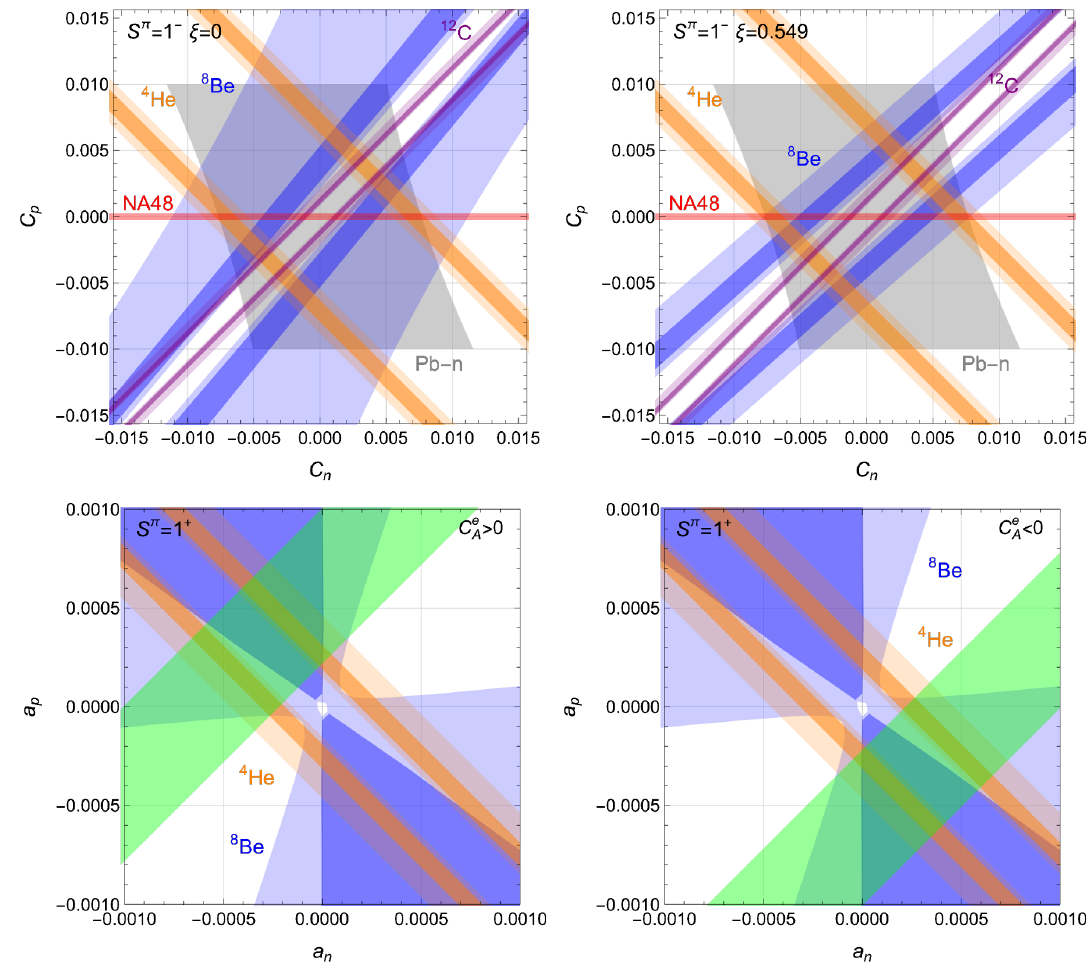
Figure 5 . Upper panels: Regions of the C n,p effective nuclear couplings of a pure vector state where the 8 Be (blue), 4 He (orange) and 12 C (purple) anomalous ATOMKI transition can be explained at 1 σ or 2 σ . Inside the red and the gray region, respectively, the NA48 and the 208 Pb-n scattering bound are satisfied. In the left and right panel we assume ξ = 0 and ξ = 0 . 549 respectively, see axial vector state where the 8 Be (blue) and 4 He (orange) anomalous ATOMKI transition can be explained at 1 σ or 2 σ . In the green region the KTeV anomaly in π → e + e − decay can be satisfied, by assuming a positive (left panel) and negative (right panel) value for the C e axial coupling of the A X boson to electrons that can explain the anomalous ( g − 2) e , see main text for more